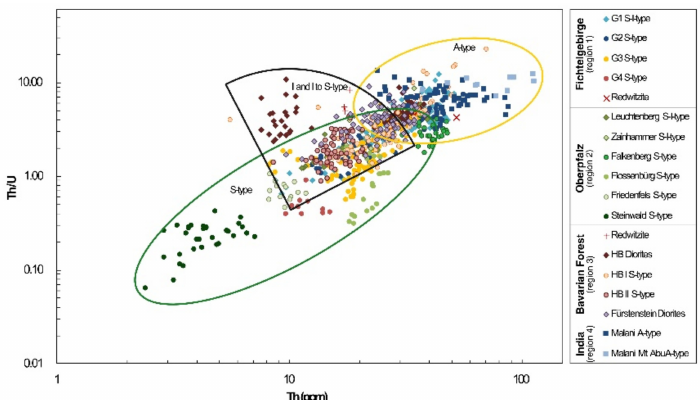
Figure 9. Th/U versus Th for all samples. Considering all data, increasing Th concentrations correlate with increasing Th/U ratios. The S-type granites show the lowest average Th/U ratios, followed closely by the S- to I-type granites. The I-type granites have, on average, higher Th/U ratios and the A-type granites, on average, the highest Th/U ratios.